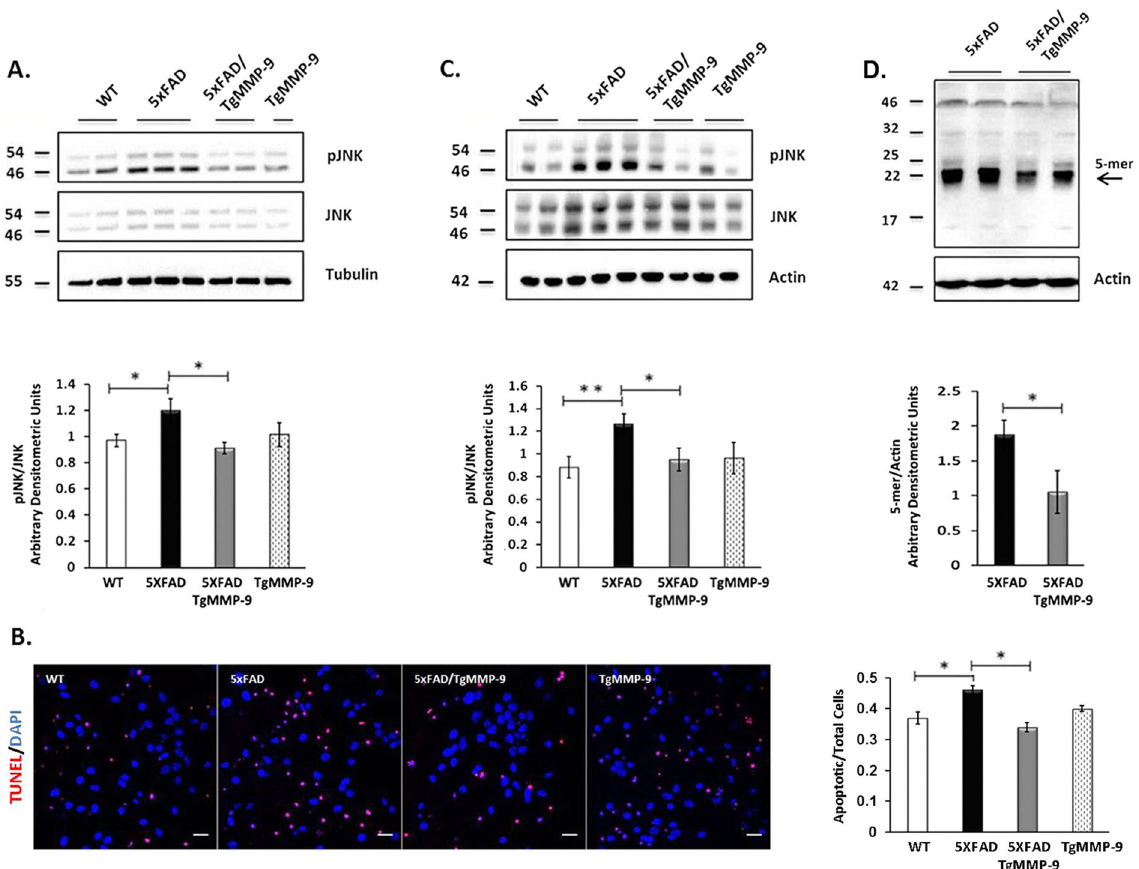
Figure 6. Representative Western blots of protein samples from primary hippocampal cell lysates ( A ) and hippocampal homogenates from 3 month-old mice ( C ) of WT, 5XFAD, 5XFAD/TgMMP-9 and TgMMP-9 mice. Equal amounts of total protein were analysed on 7.5% SDS-PAGE gels and immunoblotted with primary antibodies against pJNK and JNK. To ensure equal loading, membranes were re-probed against β -Actin or β -Tubulin. Graphs depict densitometric quantification of phosphorylated proteins normalized to their respective total protein levels. ( B ) Representative images of primary hippocampal cultures of WT, 5XFAD, 5XFAD/TgMMP-9 and TgMMP-9 mice labelled with TUNEL staining. Apoptotic cells are depicted in red and cell nuclei with stained with DAPI are depicted in blue. Graph depicts apoptotic cell number relative to total cell number. Magnification 63x. Scale bar: 20 μ m. ( D ) Equal amounts of total protein from hippocampal soluble fractions from 3 month-old 5XFAD and 5XFAD/TgMMP-9 mice were analysed on 16% SDS-PAGE gels and immunoblotted with primary antibody against human anti-6E10. n = 6–7 ( A ), n = 3 ( B ), n = 6–10 ( C ), n = 3 ( D ). All data are presented as mean ± SEM ( * p < 0.05, ** p < 0.01). Lanes were run on the same gel but were noncontiguous. Full-length images are presented in the Supplementary